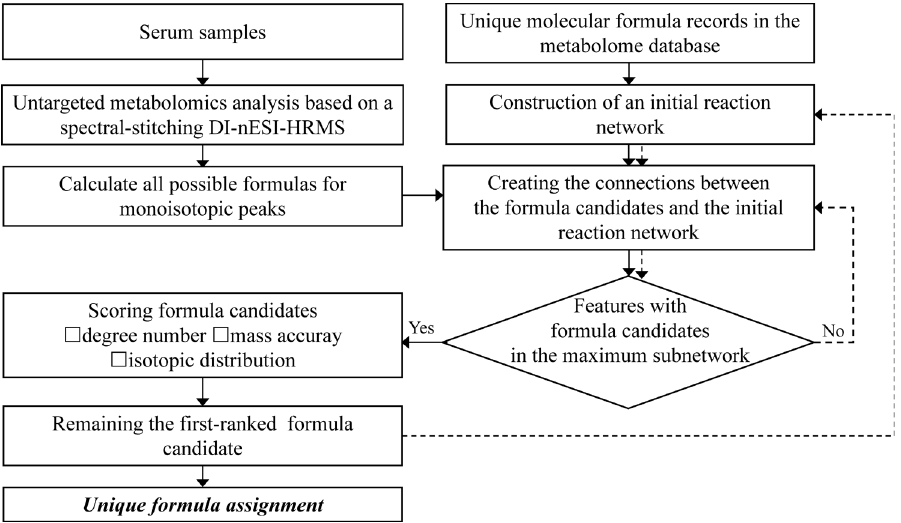
Figure 1. The workflow of a comprehensive serum metabolome analysis based on DI -nESI HRMS.